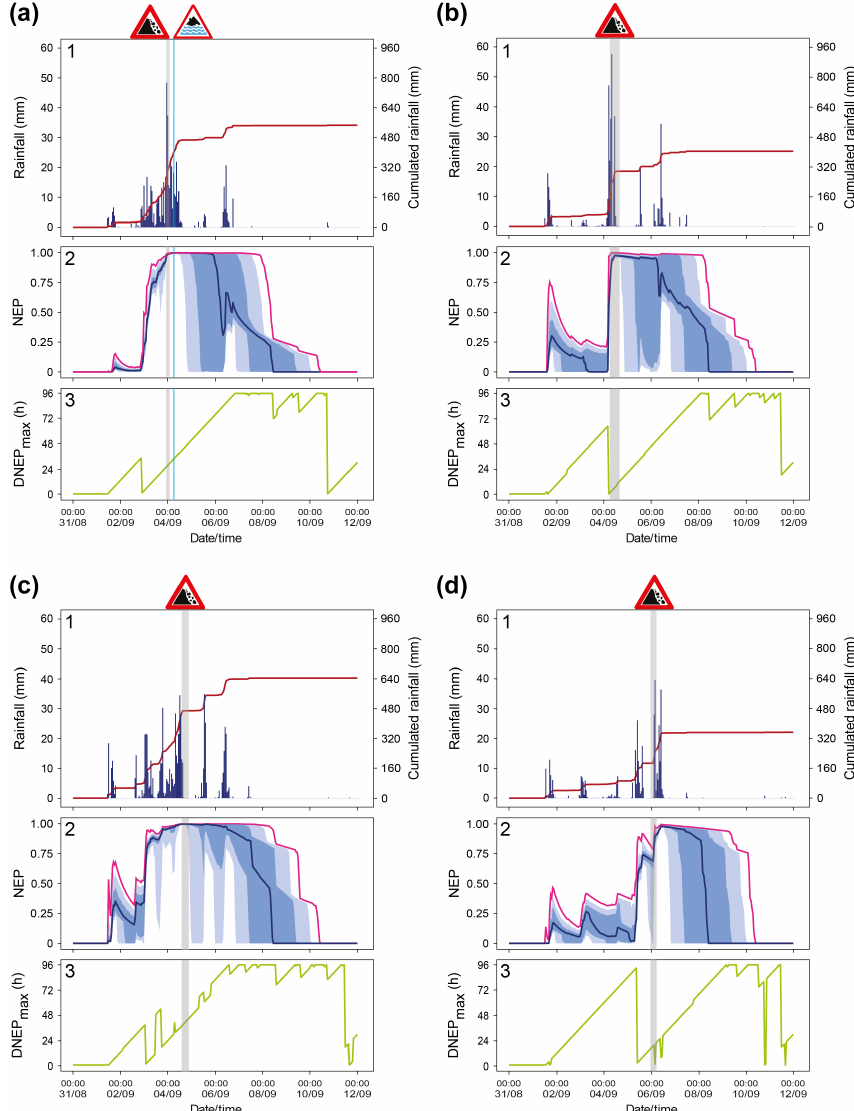
Figure 10. Results of the application of the E-NEP algorithm to synthetic rainfall records reconstructed for the locations of four landslide clusters. (a) Landslide cluster A, (b) landslide cluster B, (c) landslide cluster C, (d) landslide cluster D. Each panel shows, from top to bottom, (1) hourly rainfall record (blue bars) and cumulated event rainfall (red line); (2) median, E-NEP 50 (orange line) and maximum, E-NEP max (purple line) values of the non-exceedance probability with ranges E-NEP 25 –E-NEP 75 (dark blue shade) and E-NEP 10 –E-NEP 90 (light blue shade); (3) rainfall duration corresponding to the most critical rainfall condition, D-NEP max (green line). The period of occurrence of the landslides (identified by the landslide road sign) is shown by a grey shaded area. The occurrence time (and the associated uncertainty) of nine landslides (cf. Sect. 3.3) is used to define the landslide occurrence period of the four clusters. The time of occurrence of peak flow (identified by the flood road sign) is shown by the vertical blue line. See text for